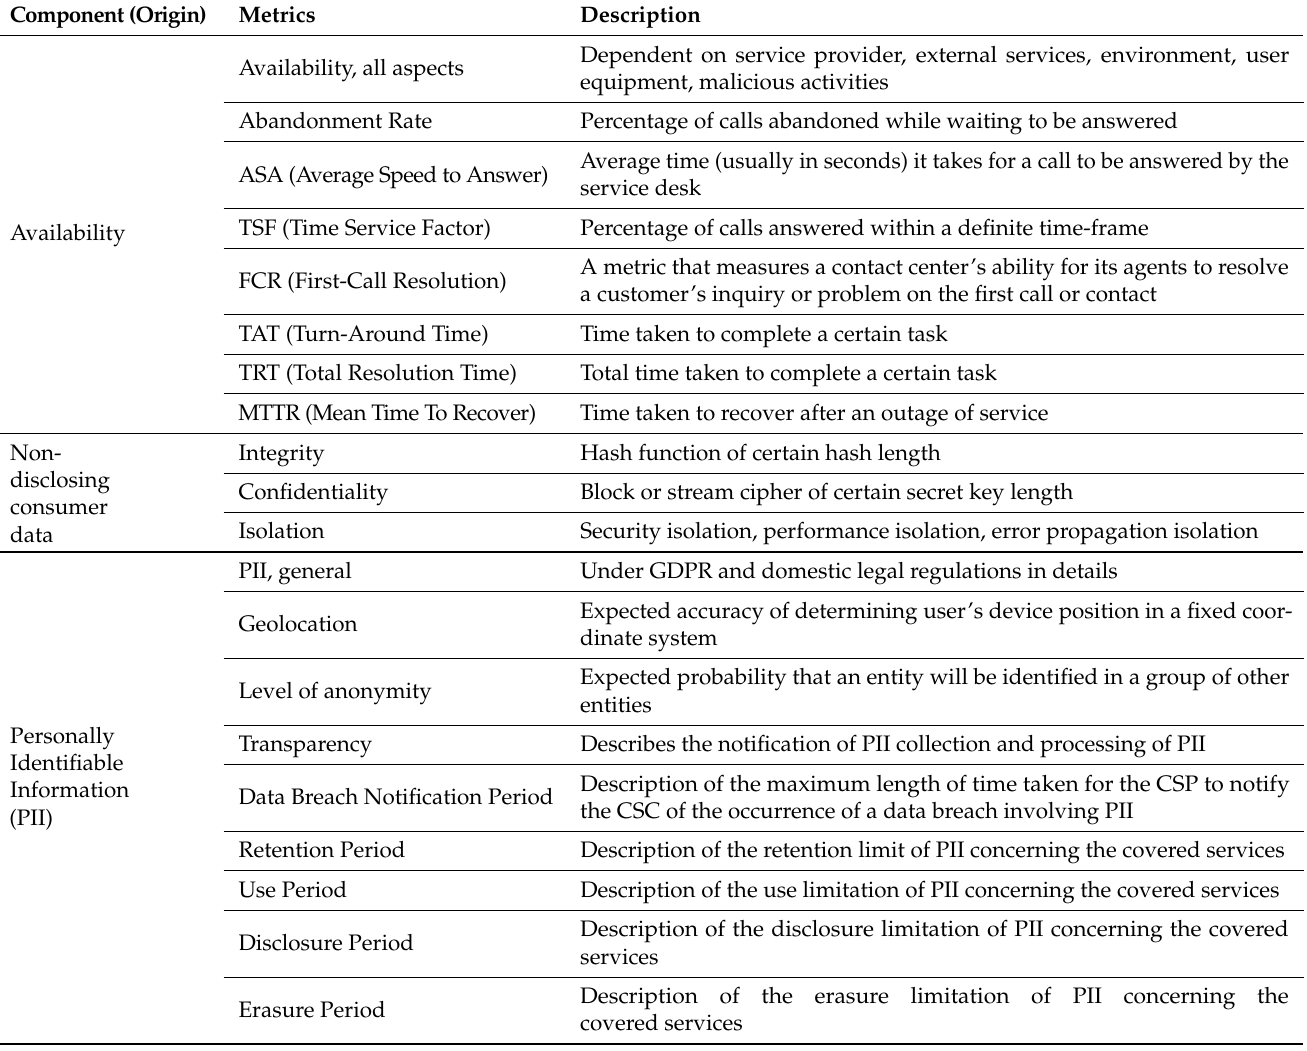
Table 2. SSLA basic components (SLO type).